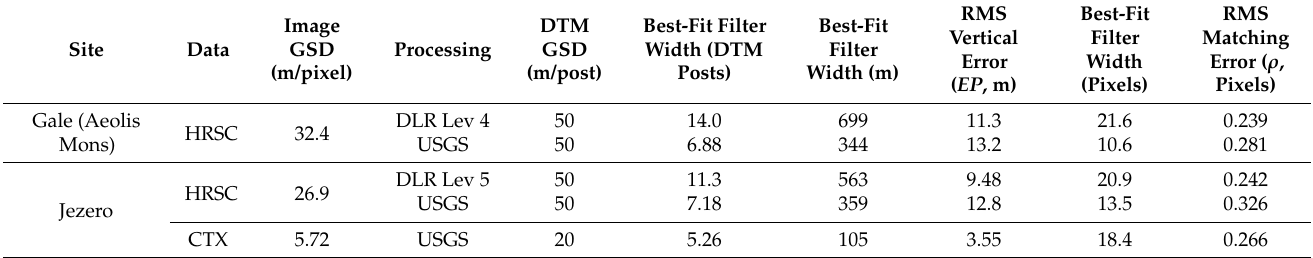
Table 1. DTM resolution and error based on comparison to smoothed HiRISE